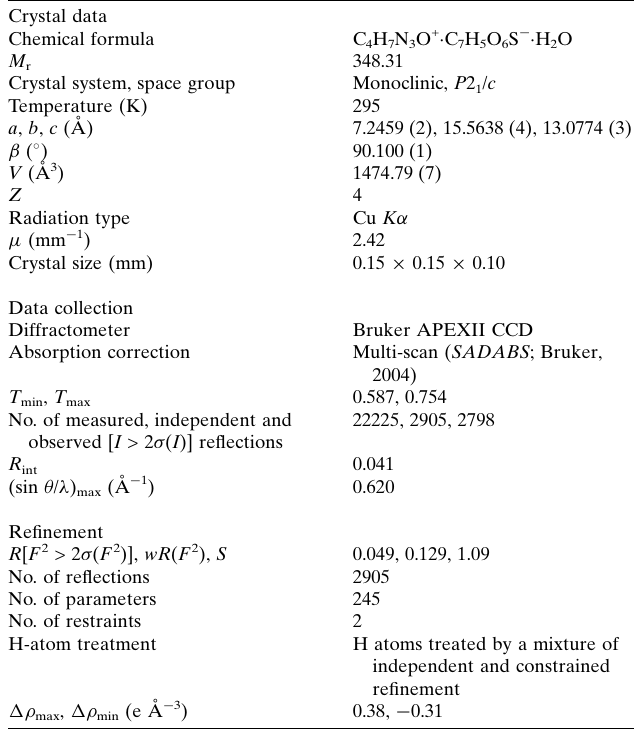
Table 2 Experimental details.